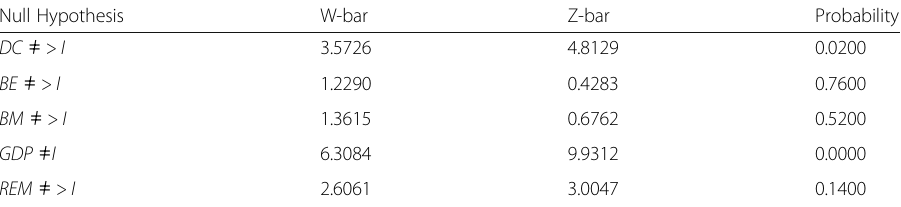
Table 10 Dumitrescu and Hurlin (2012) Granger non-causality test Null Hypothesis W-bar DC ≠ >